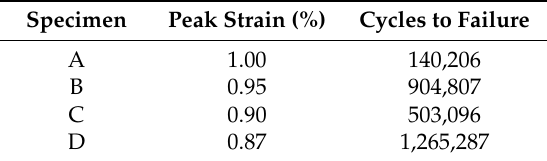
Table 2. Table of results from tensile fatigue testing of four coupons.